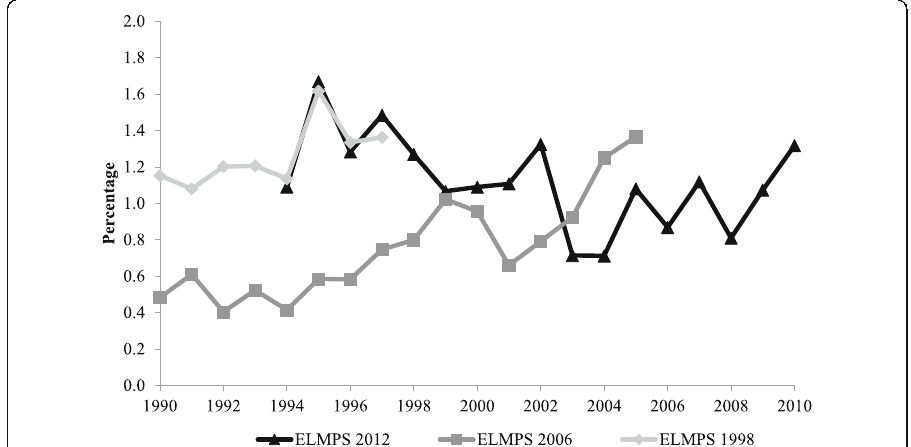
Fig. 7 Employment to non-employment separation rate (percentage) by wave, males aged 15 – 54, 1990 – 2010. Source: Authors ’ calculations based on ELMPS 1998, ELMPS 2006, and ELMPS